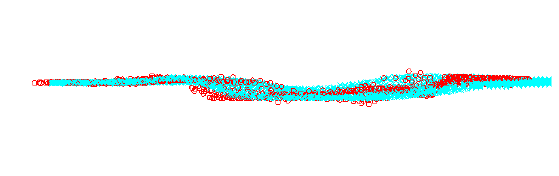
Figure 10: Superposition graph of two kinds of